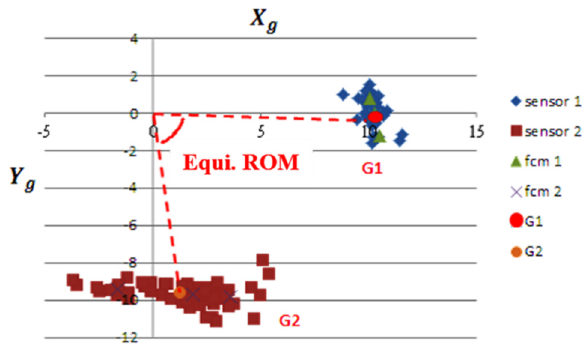
Figure 10. Equivalent ROM.